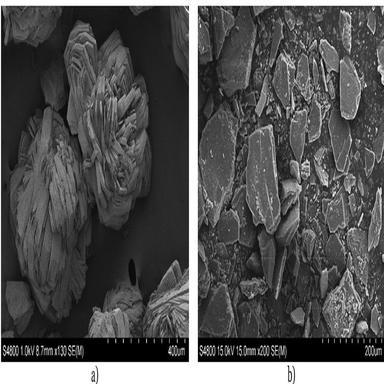
Scanning electron microscopy (SEM) image of the (a) crystals and (b) powder.